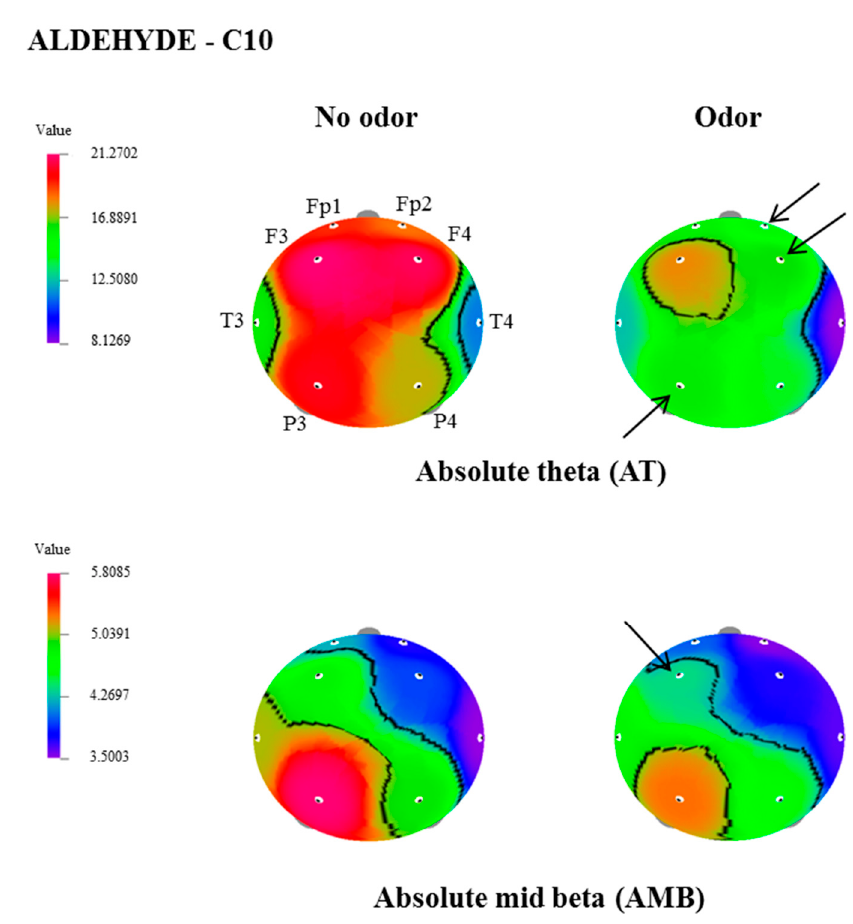
Figure 2. The t-Mapping of EEG power spectrum changes during the left nostril inhalation of C10 aldehyde. Fp1, left prefrontal; Fp2, right prefrontal; F3, left frontal; F4, right frontal; T3, left temporal; T4, right temporal; P3, left parietal; P4, right parietal. Arrows show significant changes in the regions during the inhalation of C10.